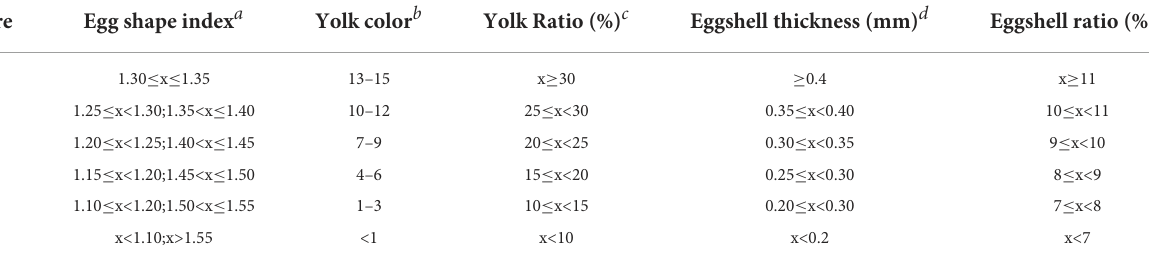
TABLE 1 Egg quality scoring